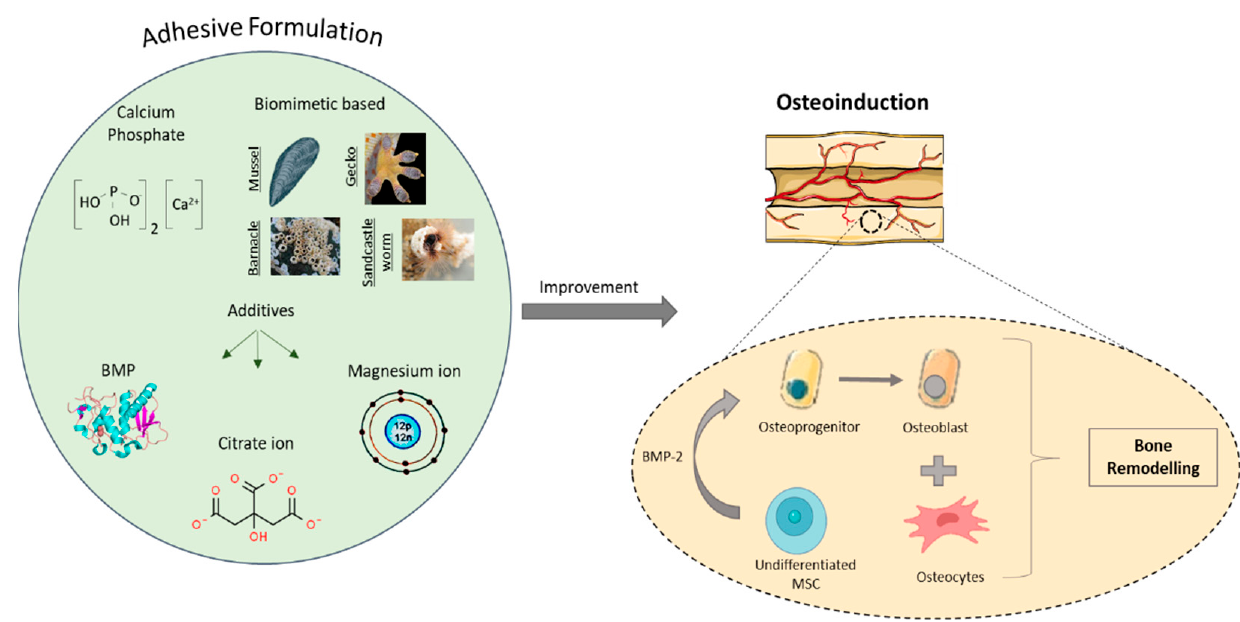
Figure 14. Improved osteoinduction can be achieved by incorporating certain growth factors, organic compounds and elements into the adhesive, thereby promoting the differentiation of undifferentiated cells into osteoblasts.